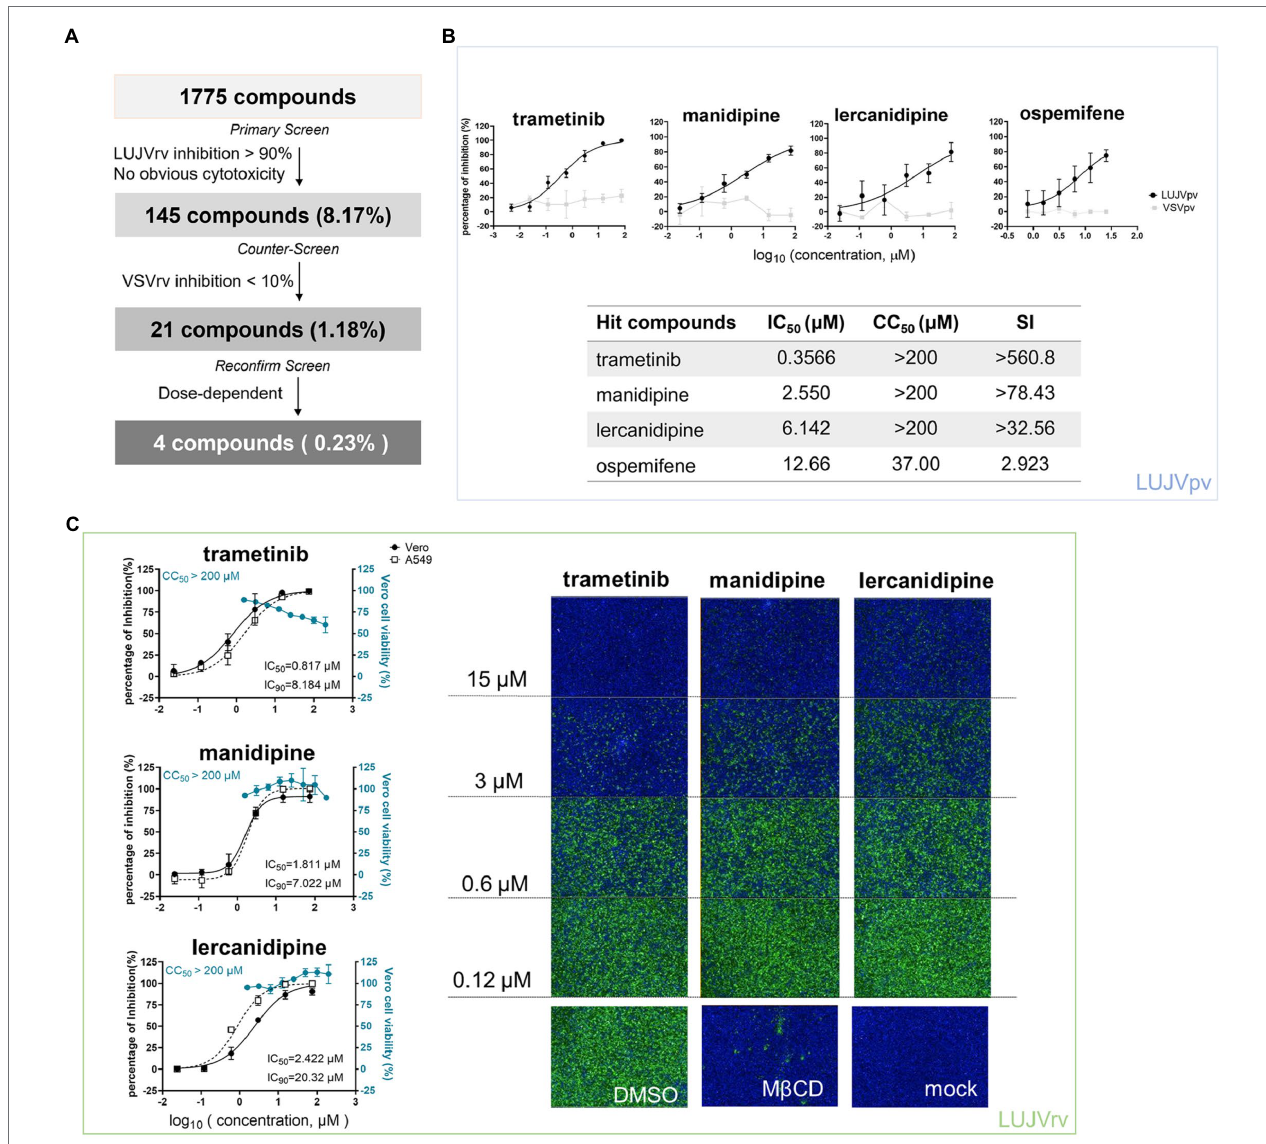
FIGURE 1 | High-throughput screening (HTS) for inhibitors of Lujo virus (LUJV) entry from an Food and Drug Administration (FDA)-approved drug library. (A) HTS assay flowchart. ( B ; Top) Dose-response curves of four hit compounds against LUJVpv. Cells were seeded at a density of 1.5 × 10 4 cells per well in 96-well plates. After overnight incubation, cells were treated in duplicate with each compound at the indicated concentrations. One hour later, cells were infected with LUJVpv (MOI, 0.01) for 1 h. The infected cells were lysed 23 h later, and their luciferase activities were measured. (Bottom) IC 50 , CC 50 , and SI values of the hit compounds. Cell viability was evaluated using MTT assay. ( C ; Left) Dose-response curves of trametinib, manidipine, and lercanidipine against LUJVrv on both Vero and A549 cells. (Right) Images showing the inhibition of the top three hits against LUJVrv infection. Vero cells were preincubated with compounds at 37 ° C for 1 h, followed by incubation with LUJVrv (MOI, 0.1) in the presence or absence of compounds for 1 h. GFP-positive cells were counted using an Operetta high-content imaging system 23 h later. Data are presented as means ± SD, from 5 to 8 independent